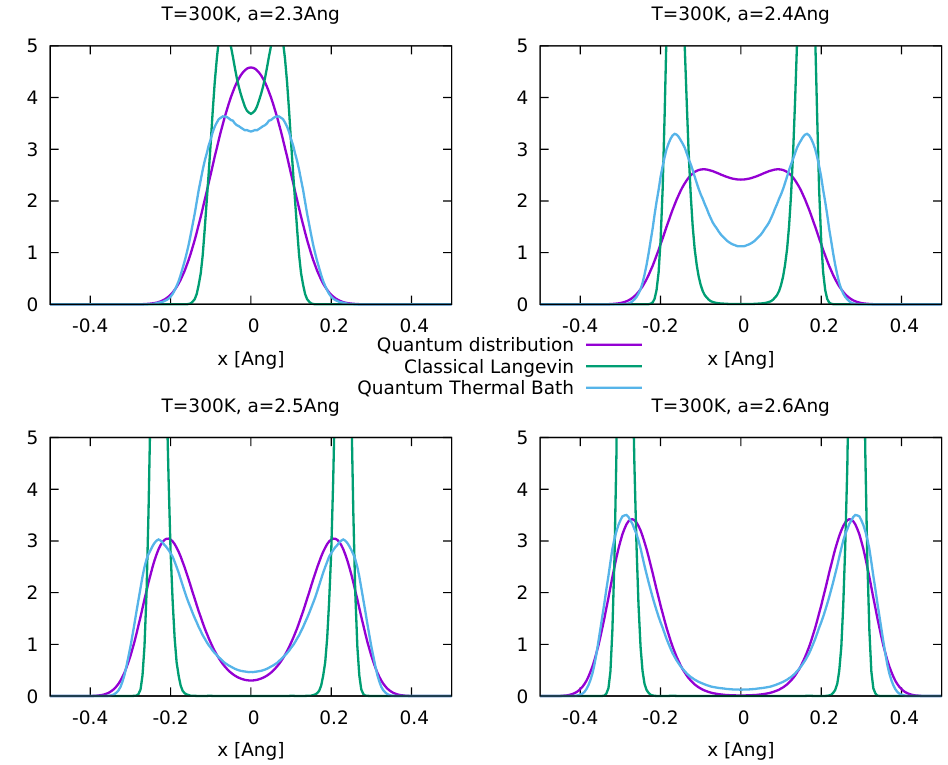
Figure A2. Probability distributions that are obtained for V ( x ) (A7) at T = 300 K for several distances a . Exact quantum distribution (magenta), classical distribution (green) and QTB distribution (blue). The damping coefficient here is γ = 0.1 THz. Setting γ to 1 THz or 10 THz does not change the resulting probability distributions